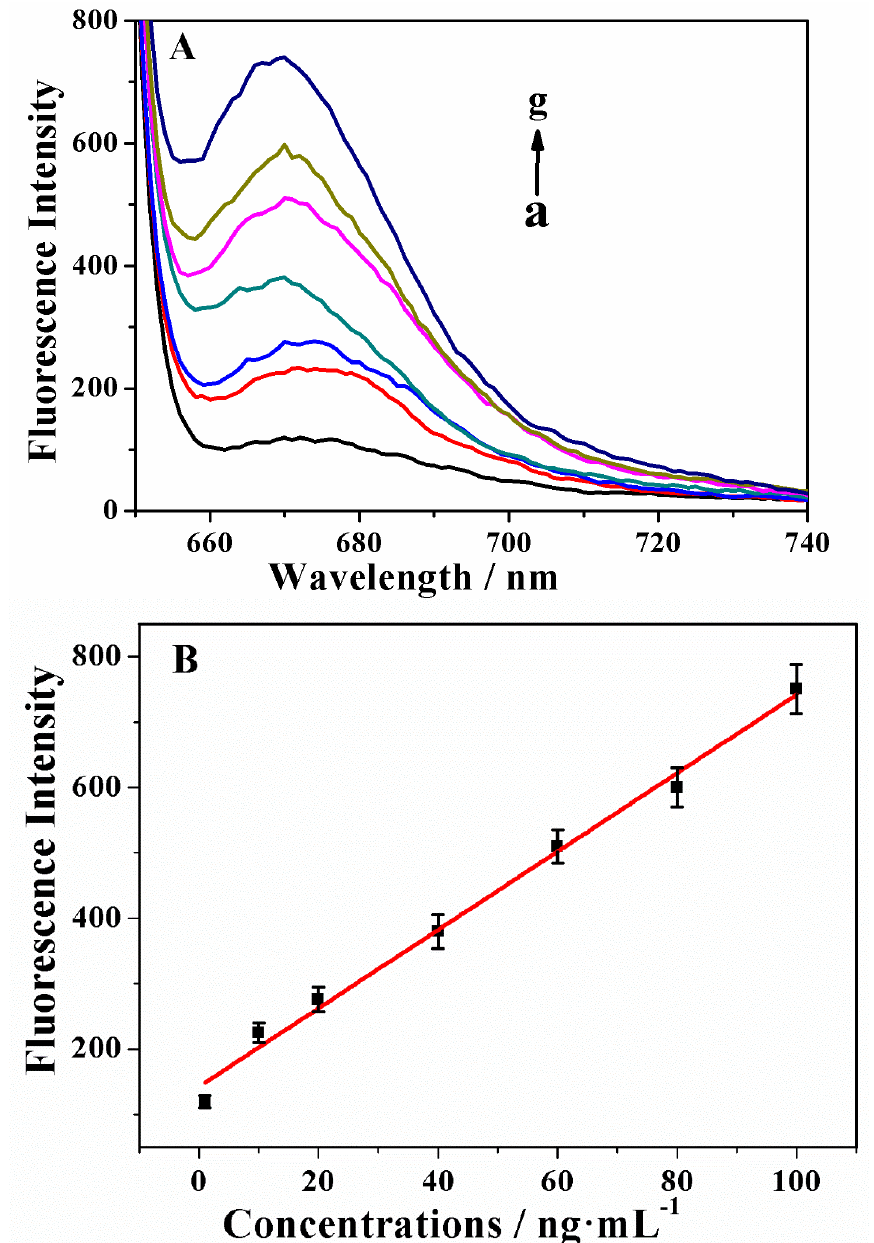
Figure 3. ( A ) Fluorescence spectra of the reaction solution in the presence of different concentrations of PDGF-BB (from “ a ” to “ g ”: 1, 10, 20, 40, 60, 80, and 100 ng·mL − 1 ) after 2 hours of reaction. ( B ) The linear relationship between the fluorescence peak intensity at 670 nm and the target PDGF-BB concentration. The error bars indicate the standard deviation of repeated three measurements.